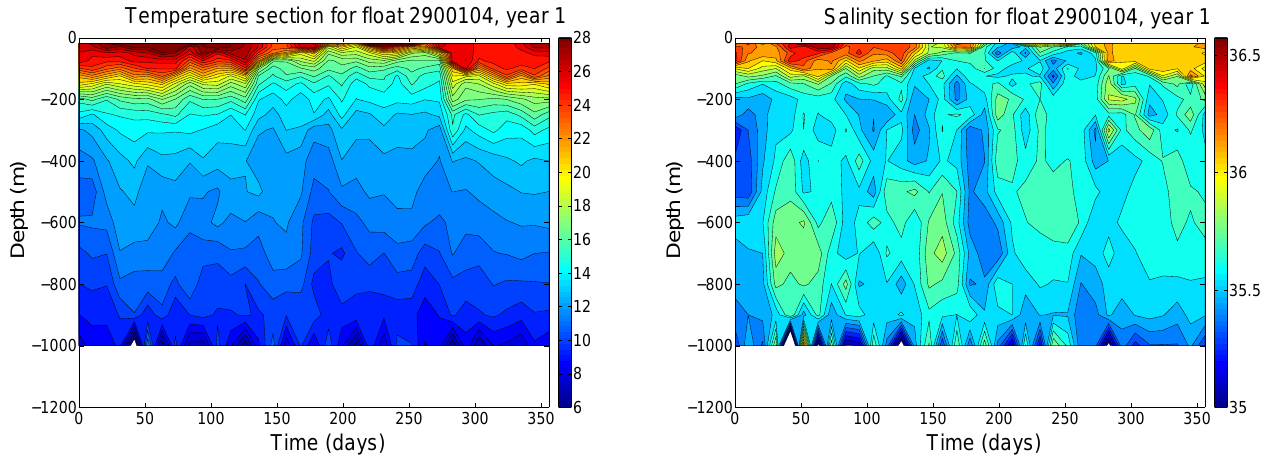
Fig. 14. Vertical sections of temperature (in ◦ C, left) and of salinity (right) along float 2900104 trajectory for year 1. Figure 14: Vertical sections of temperature (in o C , left) and of salinity (right) along float 2900104 trajectory for year 1. Colder and fresher waters were also identified at 200 depth around day 550 (early September 2007) and day 620 (mid November 2007). Indeed, in September, upwellings can develop near Ras ash Sharbatat and bring colder and fresher waters